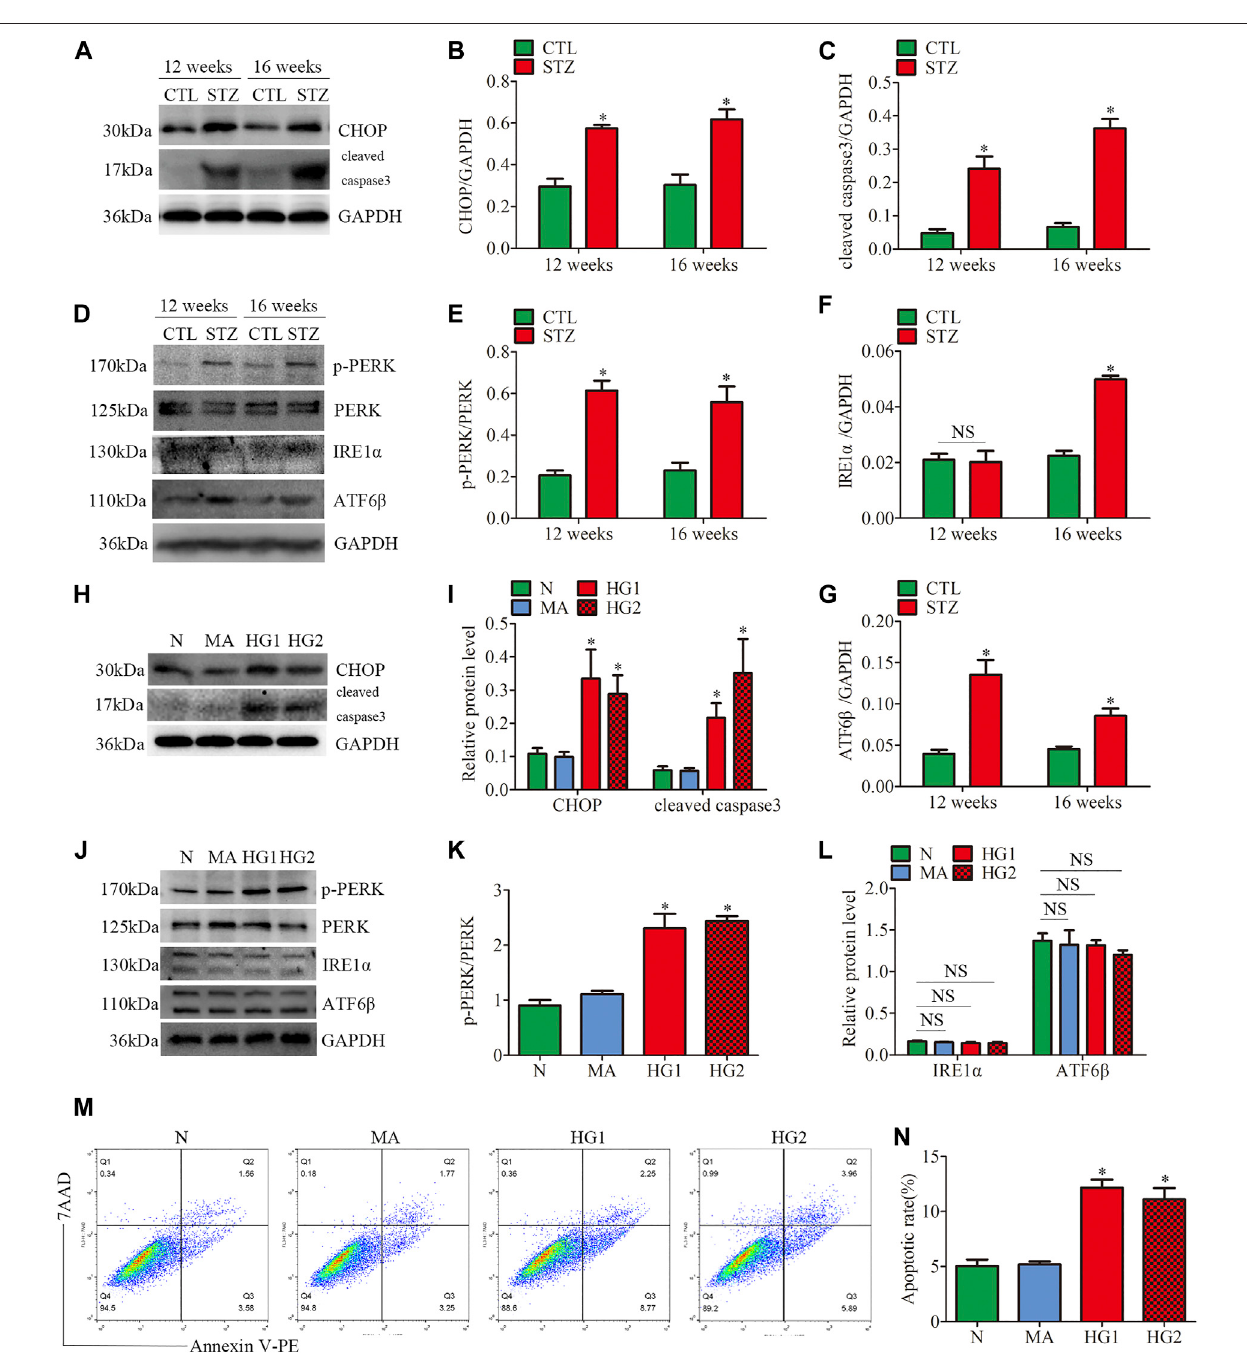
FIGURE4| ERstress-related proteinexpression andapoptosisinglomerulifromdiabeticratsandHG-treated cultured podocytes. (A – G) RepresentativeWestern blots of glomerular CHOP, cleaved caspase3, p-PERK, PERK, IRE1 α , ATF6 β expression and quanti fi cation per group (n (cid:1) 3). * p < 0.05 relative to control. (H – L) Representative Western blots ofCHOP, cleaved caspase3, p-PERK, PERK, IRE1 α , ATF6 β expression in podocytes cultured with different medium and quantitation per group(n (cid:1) 3).* p < 0.05comparedwithpodocytesculturedinnormalconditions. (M,N) Flowcytometryanalysisofapoptosisinculturedpodocytesandquantitation per group (n (cid:1) 3). * p < 0.05 compared with podocytes cultured in normal conditions. CTL, control; STZ, streptozotocin; N (cid:1) 5 mM glucose for 24 h; MA (cid:1) 5 mM glucose+20 mM mannitol for 24 h; HG1 and HG2 (cid:1) 25 mM glucose for 24 and 36 h; NS, not signi fi cant.